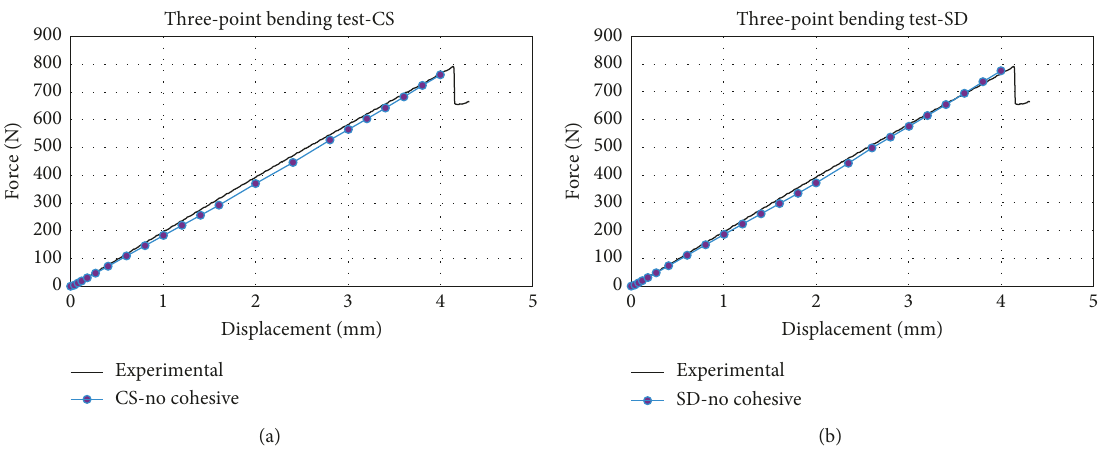
Figure 3: 3PB test: experimental-numerical comparison. (a) Continuum shell element and (b) solid